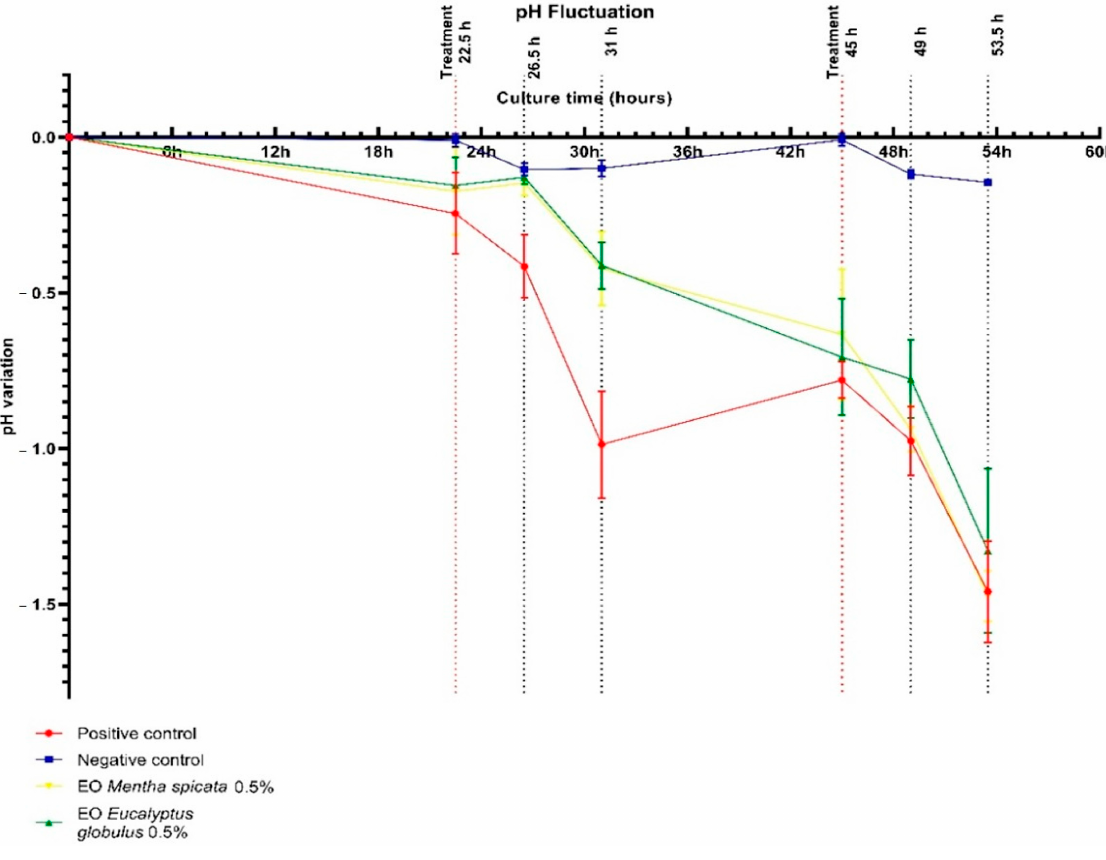
Figure 2. pH fluctuation in culture medium.